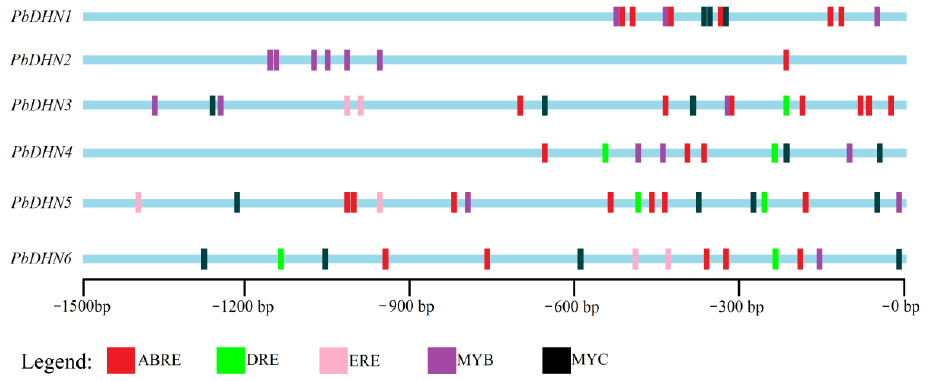
Figure 4. Location of putative cis -acting elements in the promoter regions of PbDHNs. The promoter sequences were obtained from 1500 bp upstream of the translation start codon (ATG), and the putative cold stress-related cis -acting elements were presented.